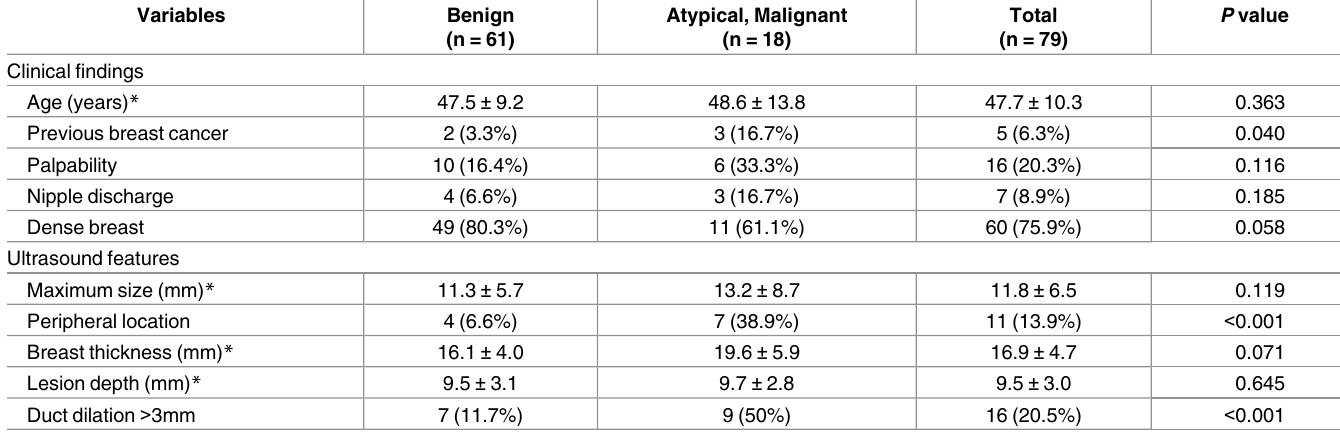
Table 2. General characteristics of the breast papillary lesions.